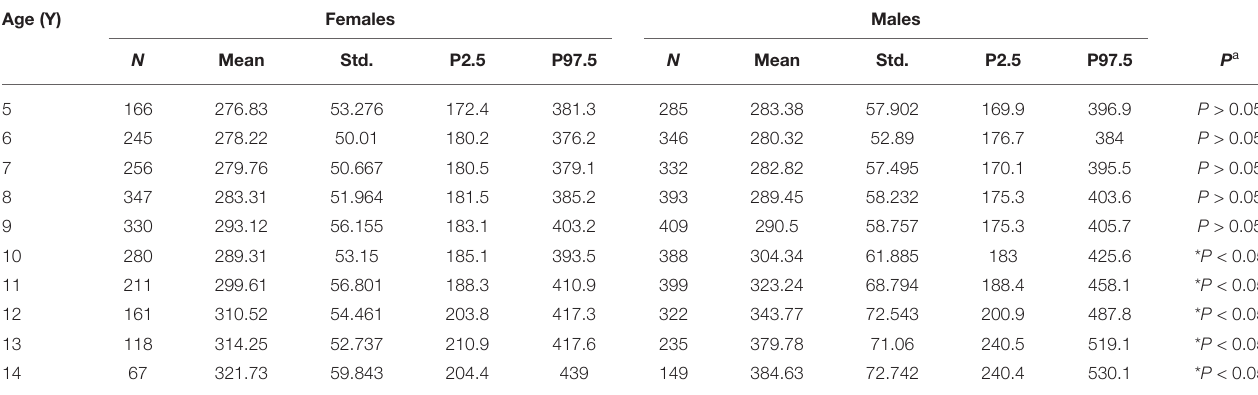
TABLE 1 | Mean, Std., and 95% reference intervals for uric acid ( µ mol/L). Age